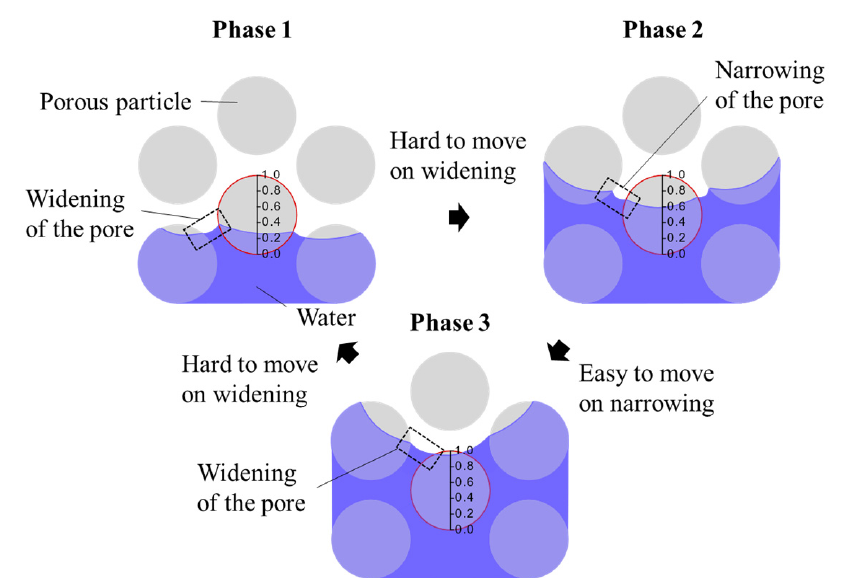
Figure 8. Diagram of the wetting process observed in this study. The scales indicate the wet part of the central beads. A high relative frequency of the wet part was observed in phases 1 and 3, which indicates that the wetting front had difficulties passing over the widening parts.